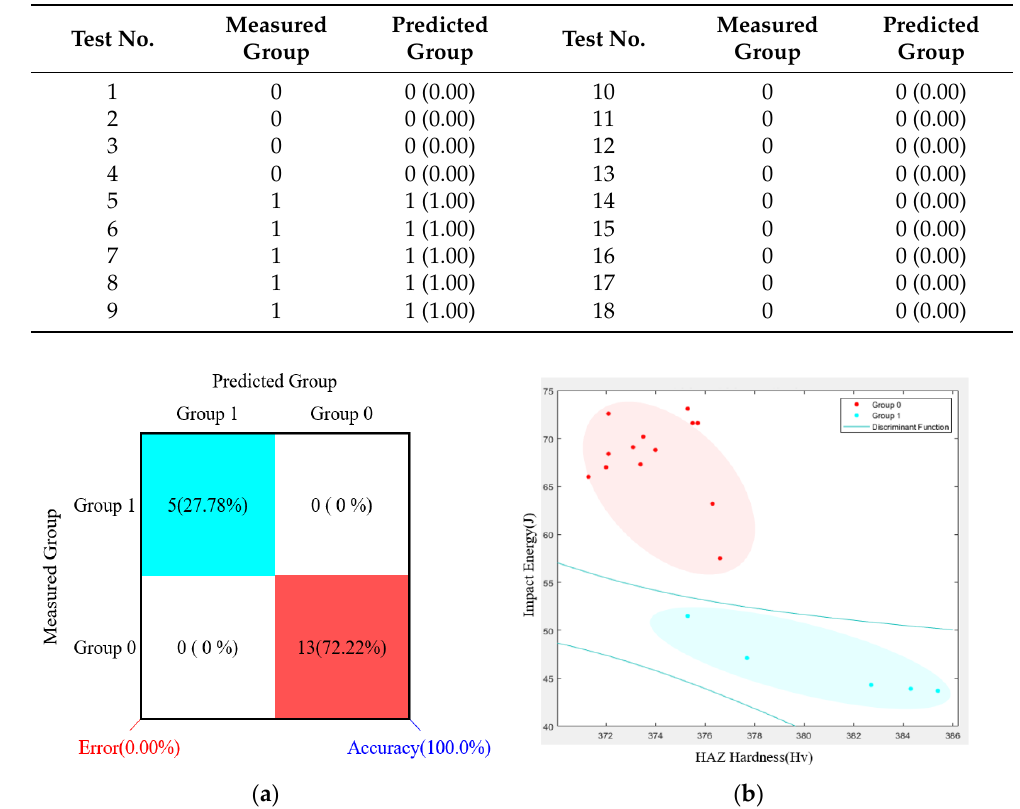
Table 11. Results of group discrimination for brittle fracture behavior according to SVM.